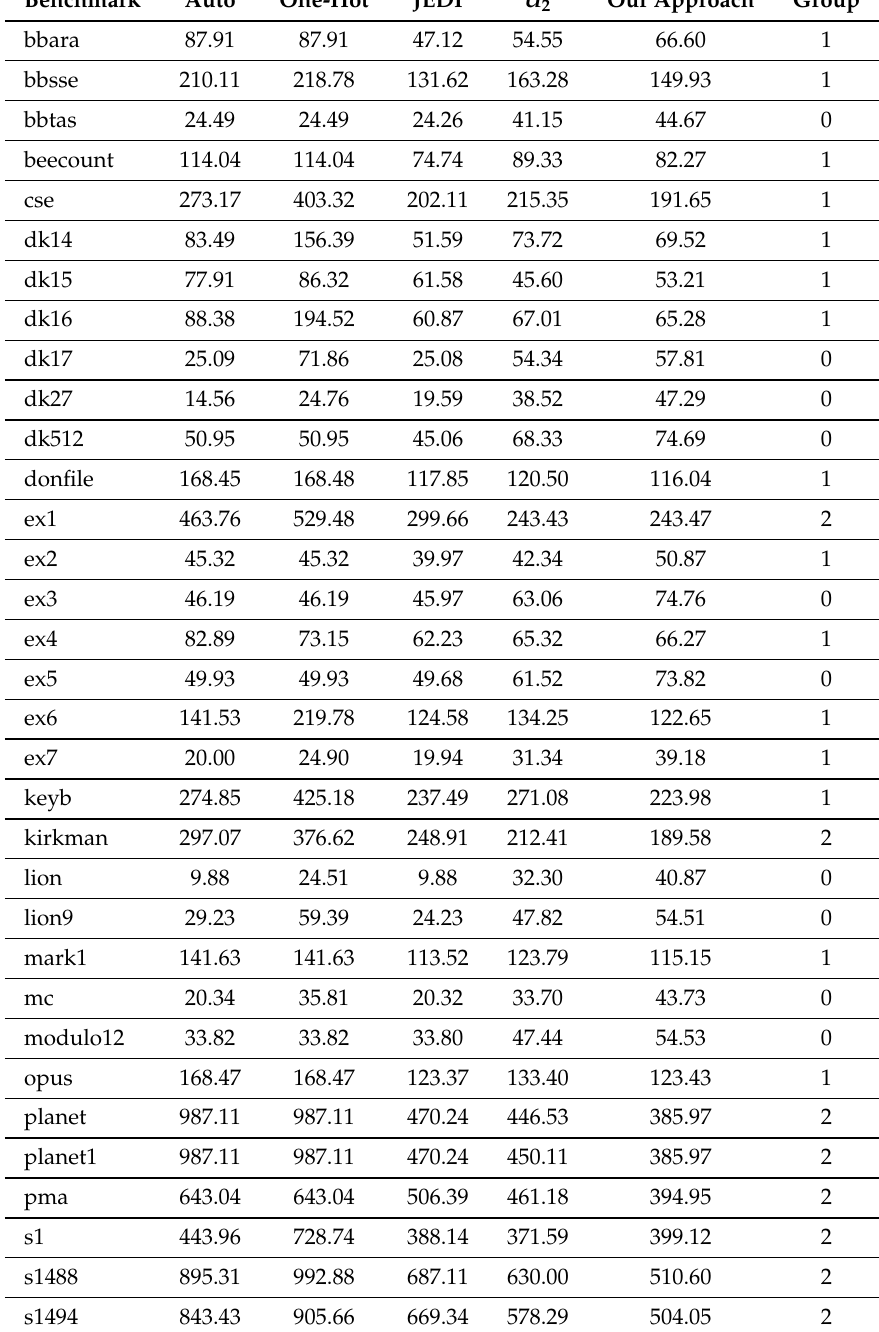
Table 16. Results of experiments (the generalized assessments, LUTs × ns